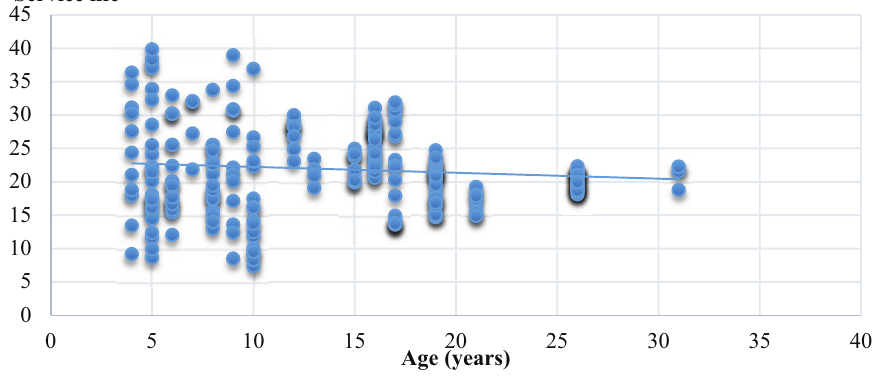
Figure 4. Service life distribution of the claddings over